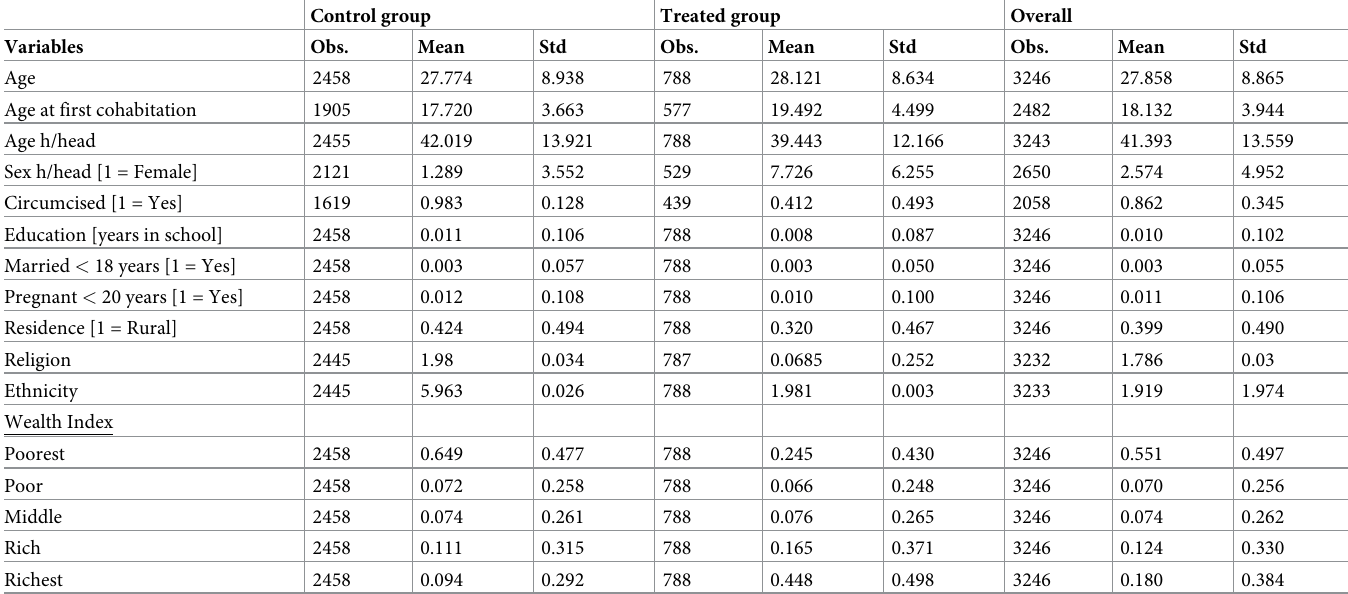
Table 1. Summary statistics, KDHS 2003, 2008–2009, and